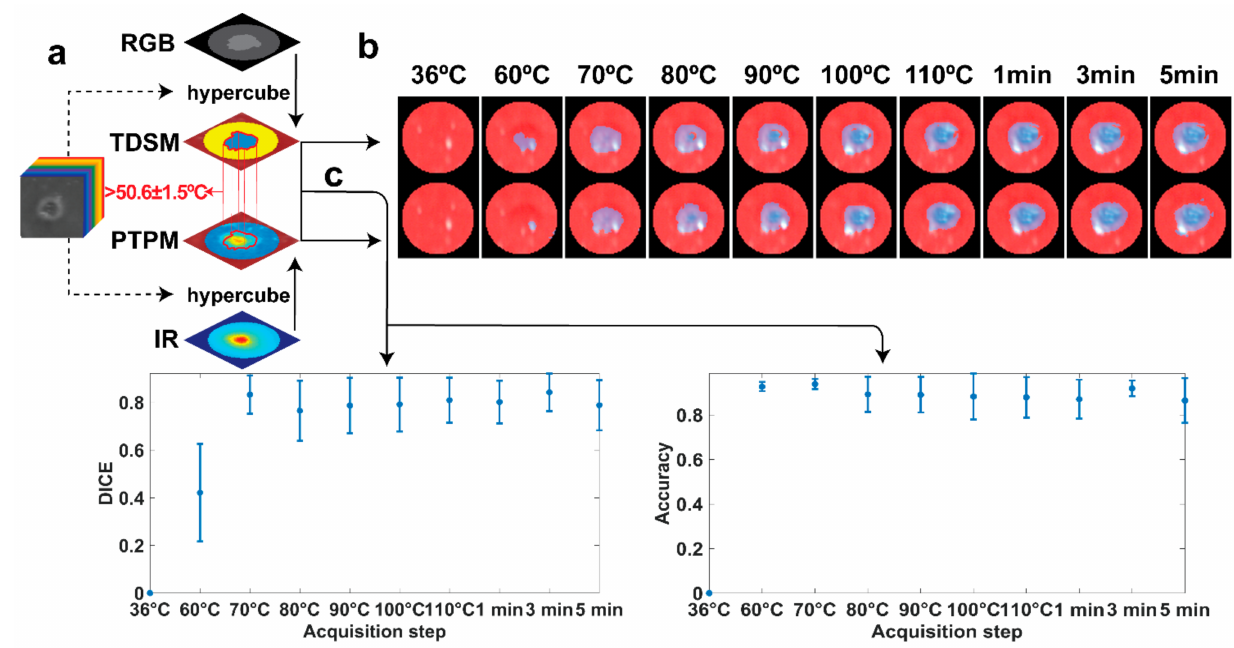
Figure 7. ( a ) Scheme demonstrating the approach used to compare the models to define the HSI abilities in margins detection. ( b ) Masks of damage for the two models overlayed on the RGB images in the ROI for all the acquisition steps of the first test. ( c ) Mean values and standard deviation for DICE and accuracy parameters defining the match between the two